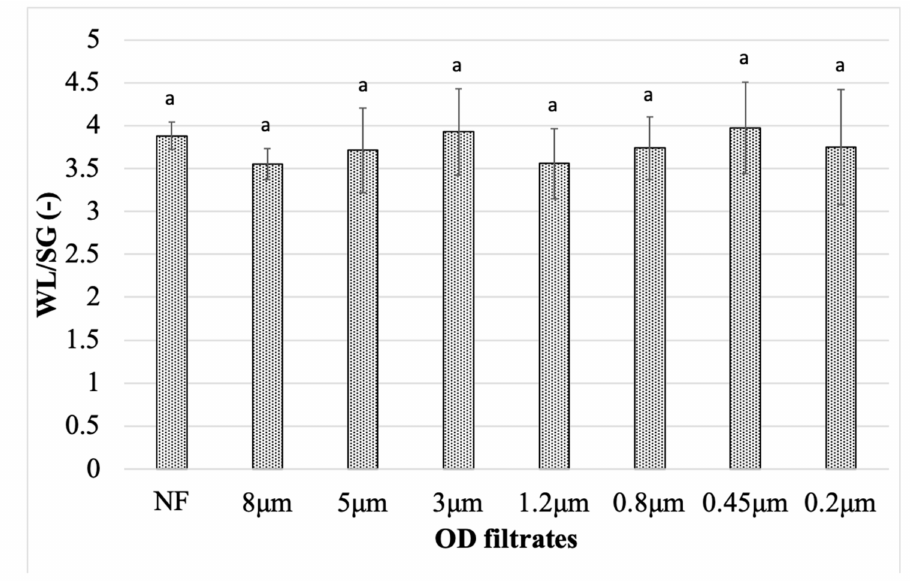
Figure 4. The mean ratio of water loss to solid gain (WL / SG) during osmotic dehydration of pumpkin slices in non-filtrated and filtrated osmotic solutions. Mean values followed by the same letter were not significantly di ff erent ( p < 0.05) according to the HSD Tukey’s least significance di ff erence